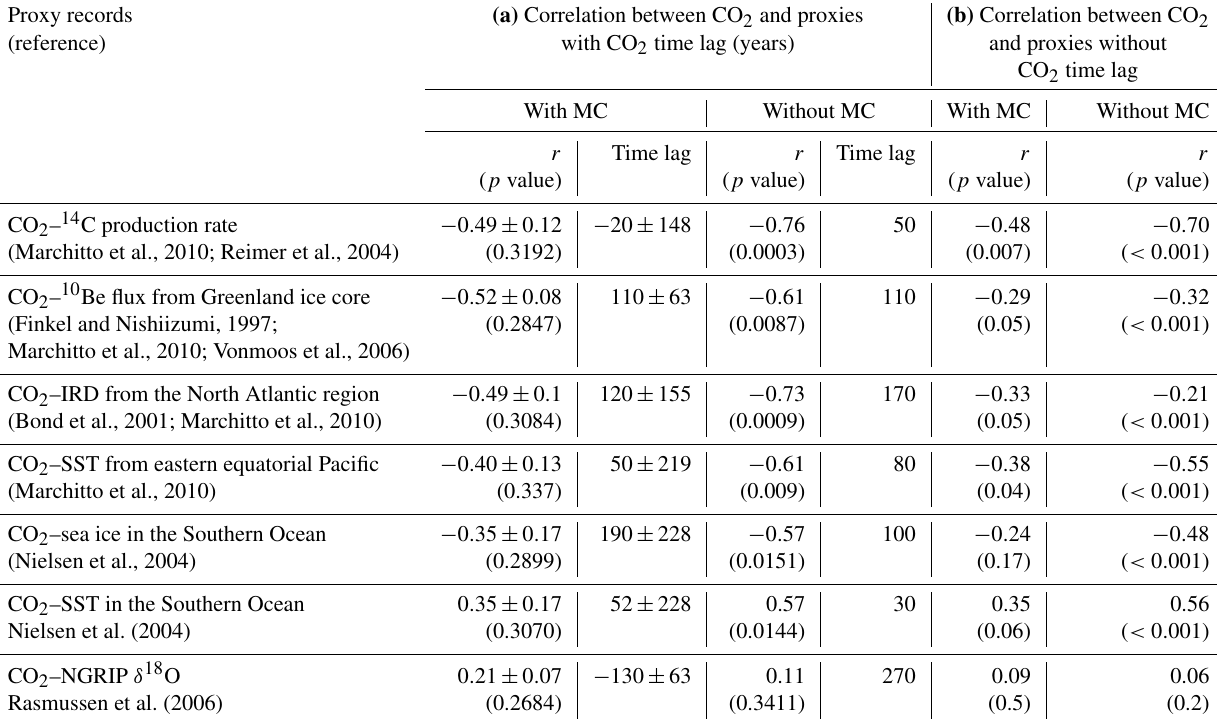
Table 2. Correlation between Siple Dome CO 2 record and climate proxy records. Column (a) shows correlation coefficients between CO 2 and proxies with CO 2 time lags. Column (b) shows correlation coefficients between CO 2 and proxies without CO 2 time lag. “With MC” shows mean values from the simulations taking age uncertainties into account. “Without MC” is the classic calculation of correlation, without taking age uncertainty into account. Significance of the lag correlations was assessed against 1000 repetitions of the lag correlation calculation using synthetic data stochastically generated to have the same red noise characteristics as the original